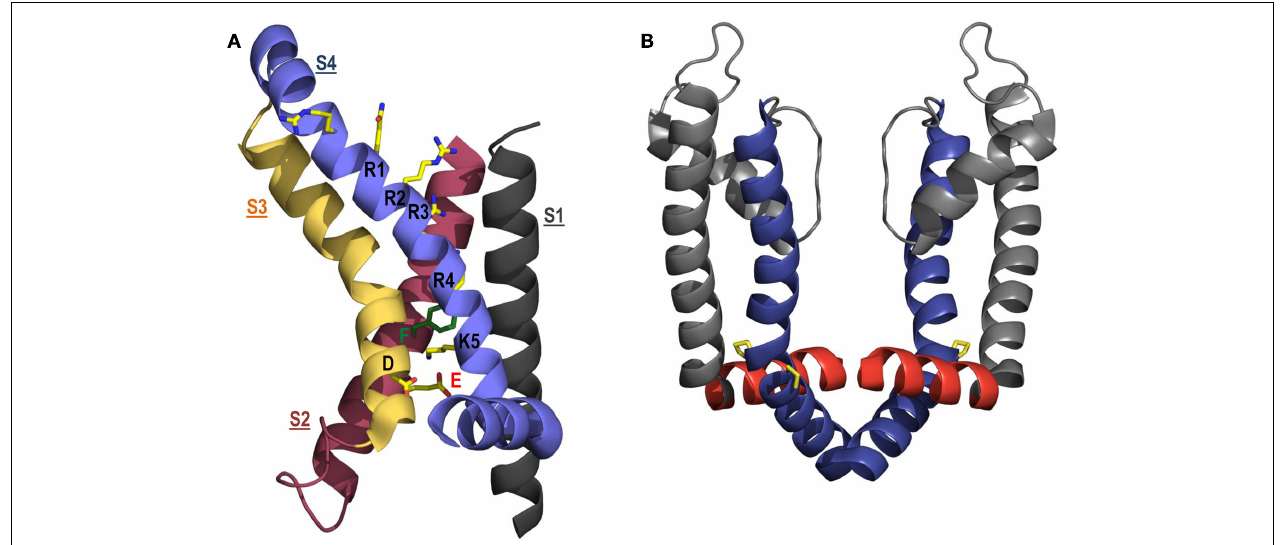
(B) Ribbon representation of the open pore domain (S5, gray; S6, blue) and S4–S5 linker (red), based on the Kv1.2–Kv2.1 chimera crystal structure, showing the close apposition of the S4–S5 linker and distal S6 helices. Proline residues that form the highly conserved PxP motif in the distal S6 helix and allow electromechanical coupling via the S4–S5 linker are highlighted in yellow. Only two subunits of the tetramer are shown (two subunits have been removed for